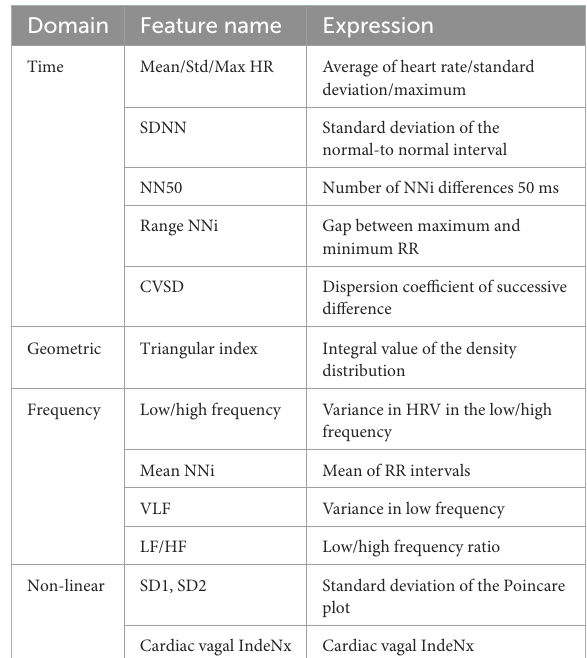
TABLE 1 Important variables among HRV